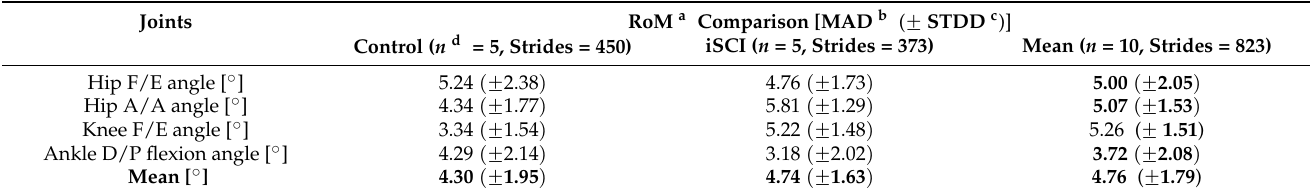
a Range of Motion (RoM); b Mean Absolute Difference (MAD); c STandard Deviation of Difference (STDD); d Number of participants